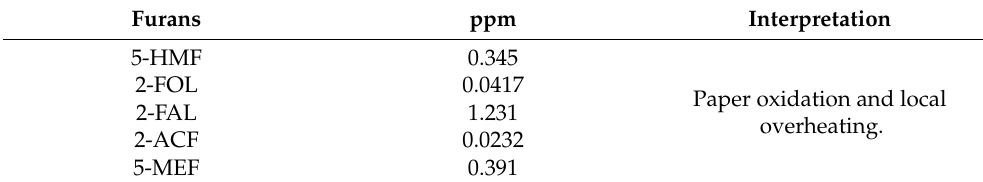
Table 13. Analysis of furans and their interpretation.